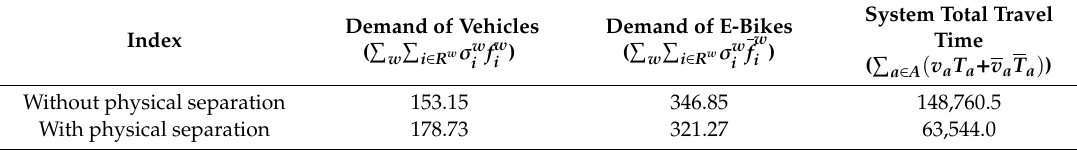
Table 4. Indicators of the NCP for cases with and without physical